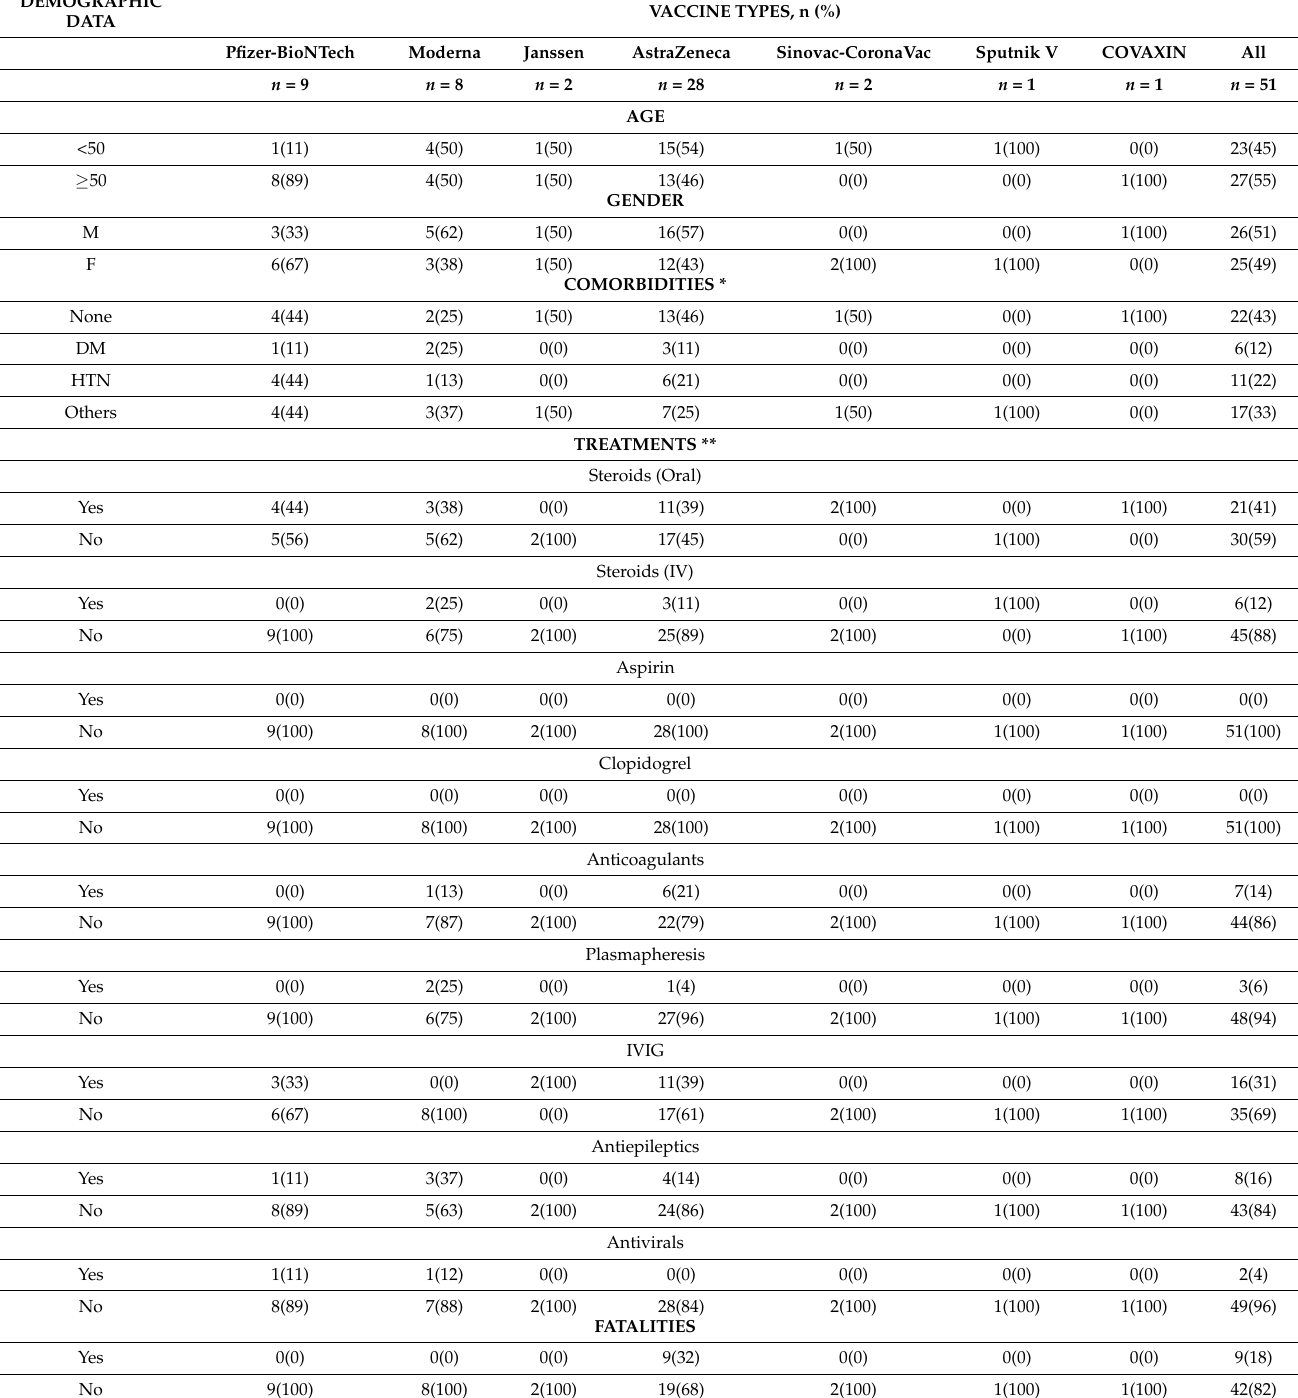
Table 2. General characteristics of patients ( n = 51) with neurological manifestations following different COVID-19